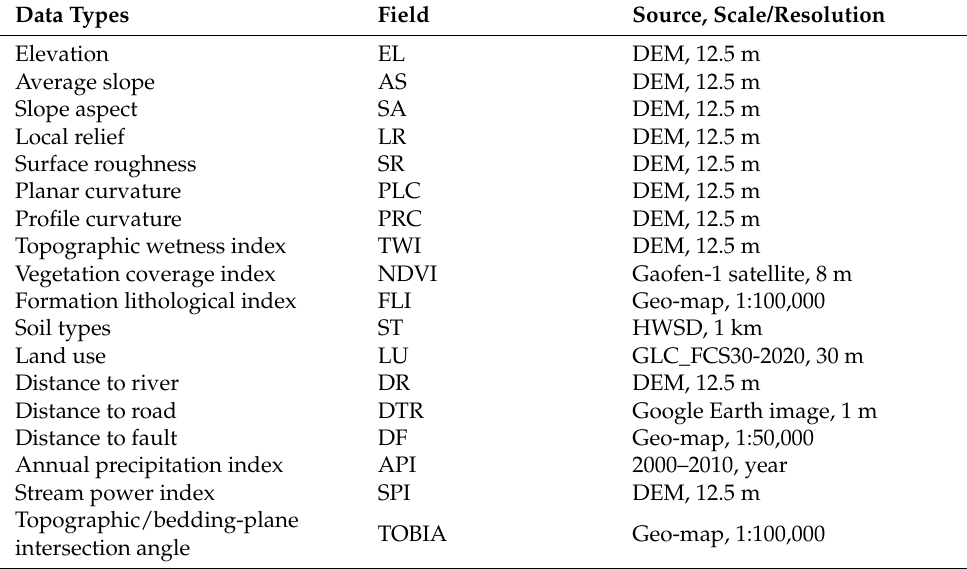
Table 1. Raster thematic maps of input